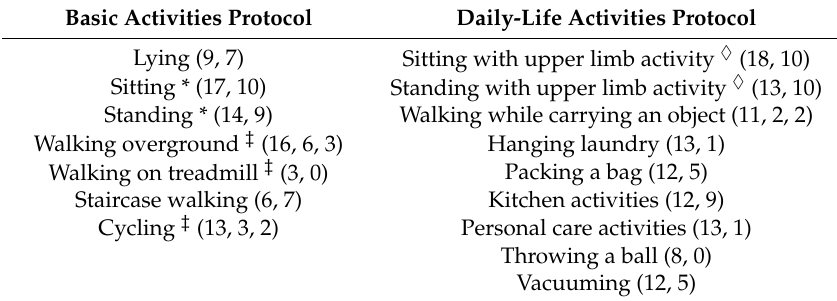
Table 1. The pre-set activities of the basic activities protocol and of the daily-life activities